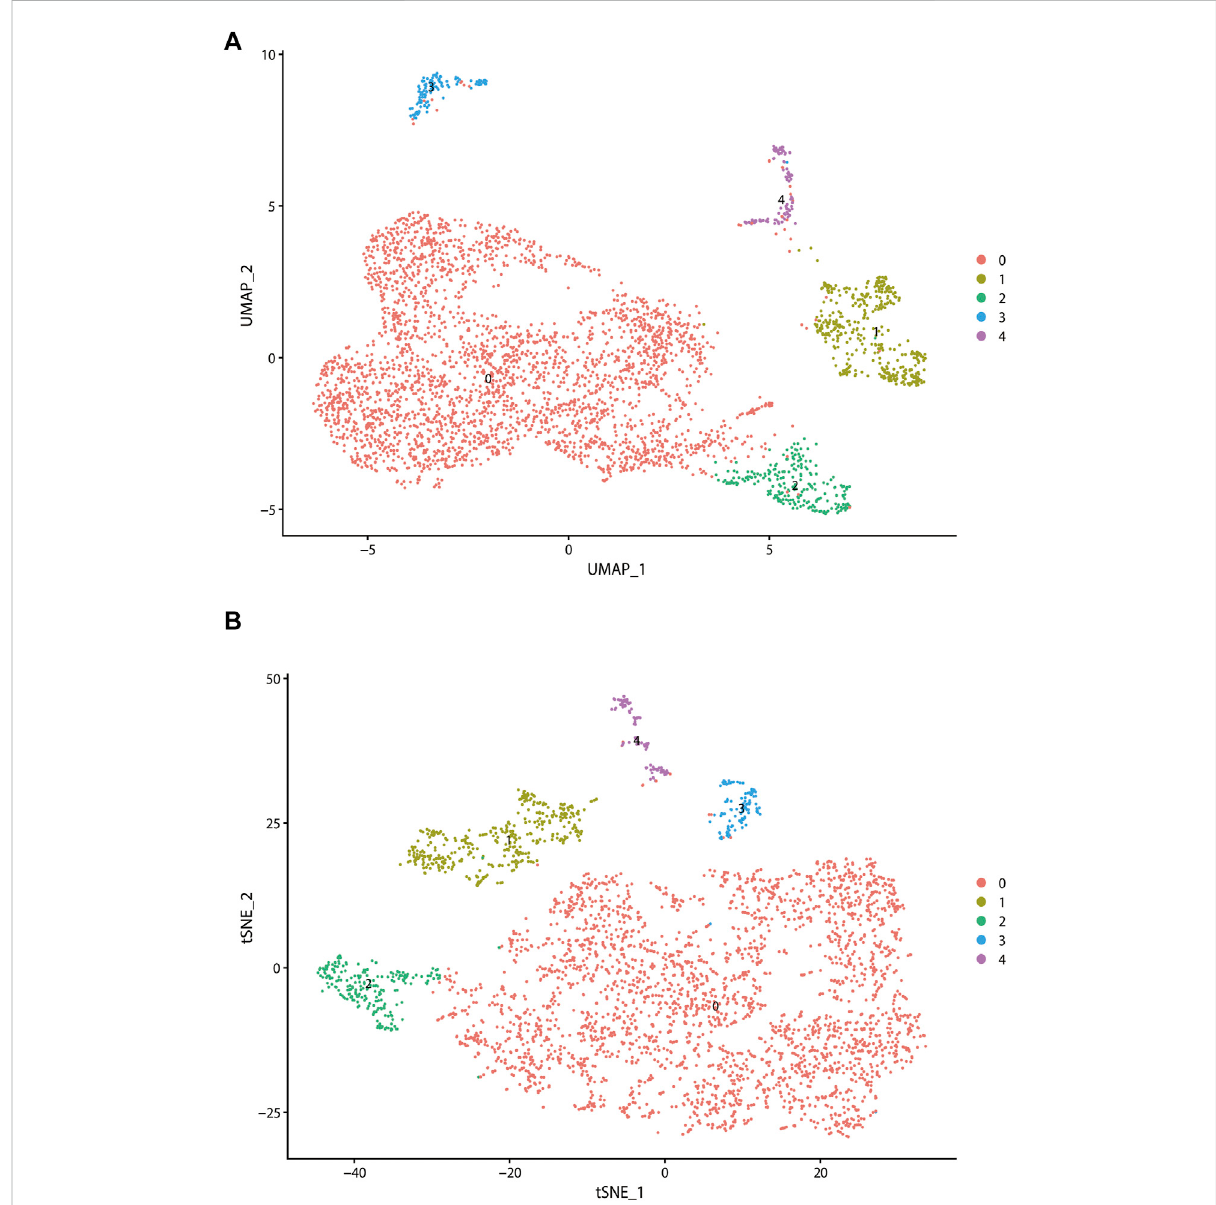
FIGURE 2 Analysis of single-cell RNA sequencing data in GSE103322, which including 18 primary HNSCC patients. All fi broblasts were isolated and clustered into 4 subtypes via t-SNE dimensionality reduction (A) and UMAP (B) dimensionality